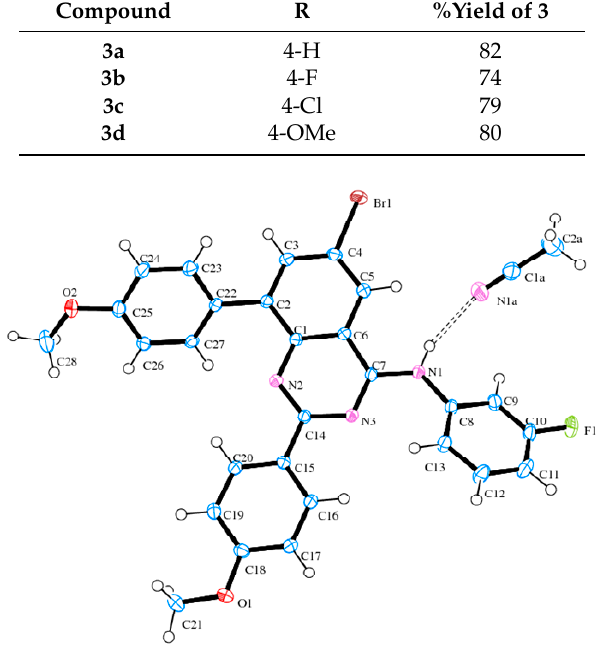
Figure 2. Oak Ridge Thermal Ellipsoid Plot (ORTERP) diagram (50% probability level) of compound 3d . Hydrogen bond is shown as dashed line.